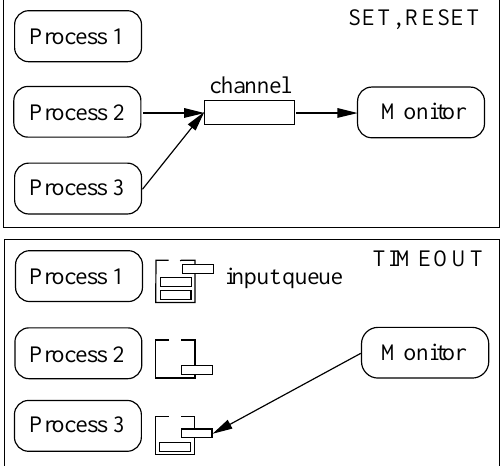
Figure 1. Basic idea of Discrete Time Model for